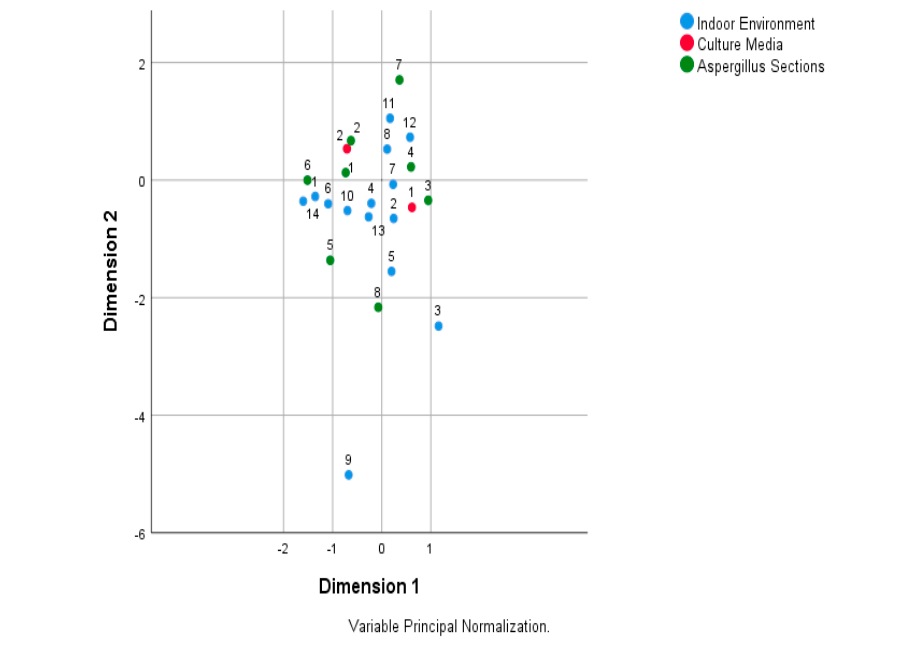
Figure 1. Joint plot of category points for Aspergillus sections, culture media, and indoor environment.